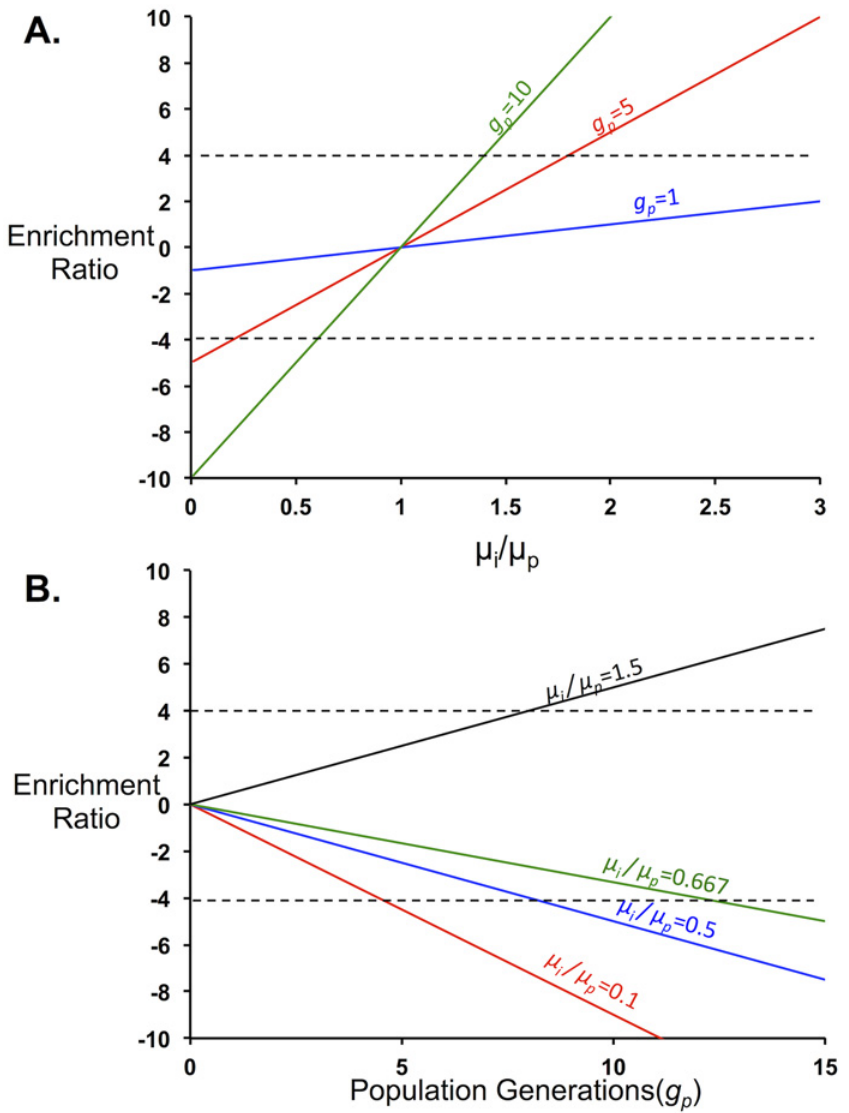
Fig 4. Growth Selection Parameters. The parameters of growth-based selections should be chosen such that the range of enrichment ratios for the population lies between-4 and 4. A . Enrichment ratios as a function of the individual growth rate compared to the population growth rate. Following one generation of population growth (blue) the enrichment ratios remain around zero. Increasing the number of population generations the experiment is allowed to grow (1 generation, blue, 5 generations, red and 10 generations, green) increases the experimental resolution in discriminating mutant growth phenotypes. B . Enrichment ratios as a function of . For m i values less than one (0.1, red; 0.5, blue; and 0.667, average population generation (g p ) for various m i m p m p green) the enrichment ratios decrease with increasing population generations. Variants with values m i values m p above one (1.5, black) show enhanced enrichment with increasing population